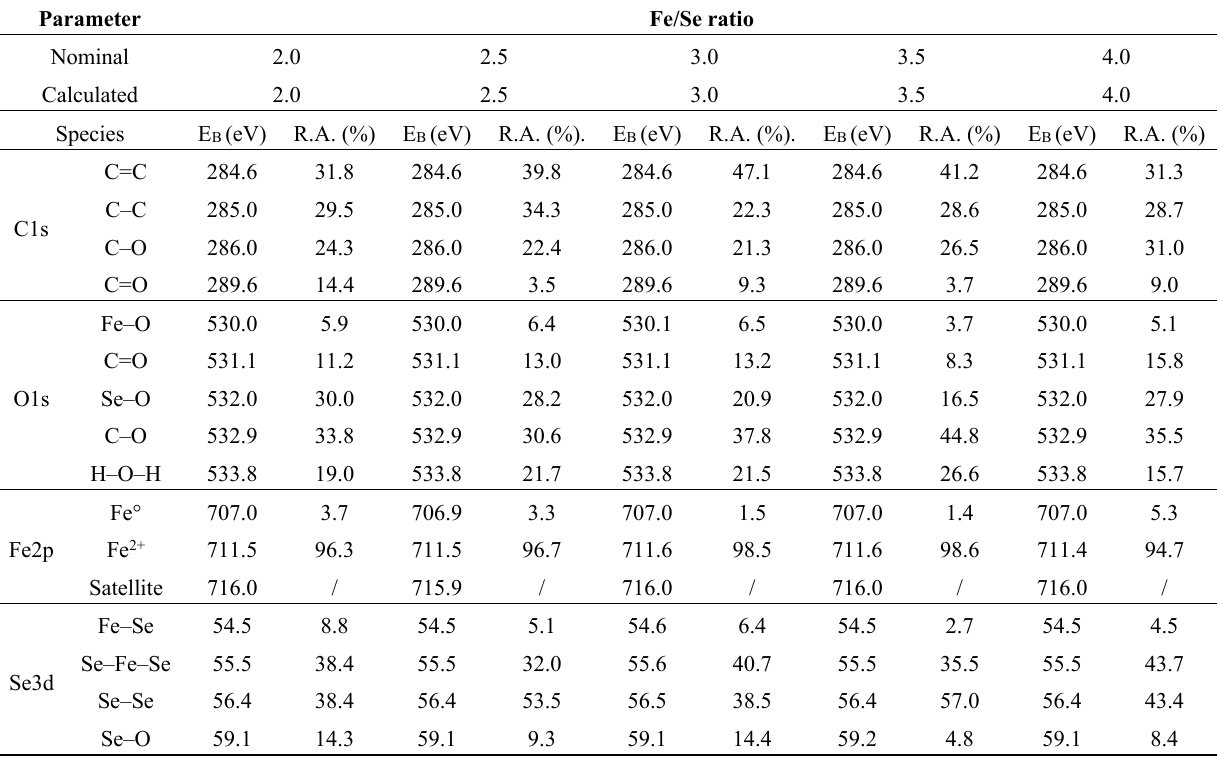
Table 2. Surface compositions of FeSe 2 /C determined based on XPS